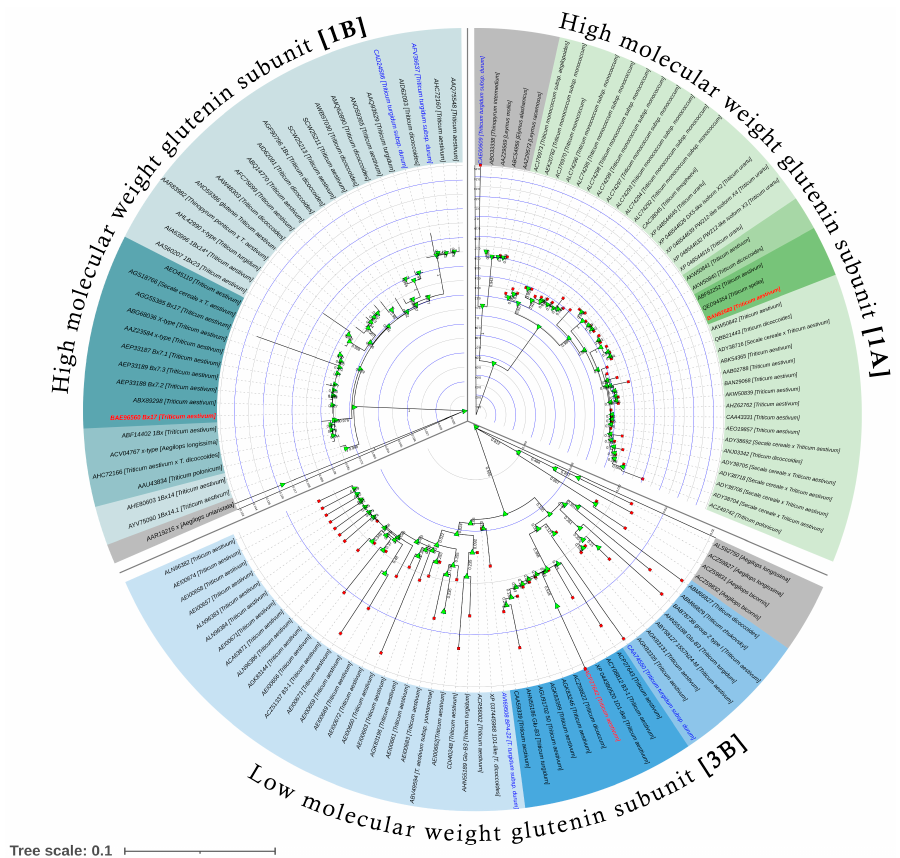
Figure 4. A phylogenetic tree showing the relationship between glutenin subunits from durum wheat, bread wheat, and their relative species. The tree was generated from the multiple sequence alignment of Glu-A1, Glu-B1, and Glu-B3 sequences in MEGA-X. The tree was rooted ontorye ( Secale cereale ) for the Glu-A1 subunit, and Aegilops uniaristata for the Glu-1B and Glu-B3 subunits. Bootstrap values were calculated from 1000 replications and only the values with 70% bootstrapping were considered significant, and are indicated on the branch nodes. The bread wheat sequences are indicated in red text, whereas the durum wheat sequences are indicated in blue text. The scale bar is shown at the bottom of the phylogenetic tree.